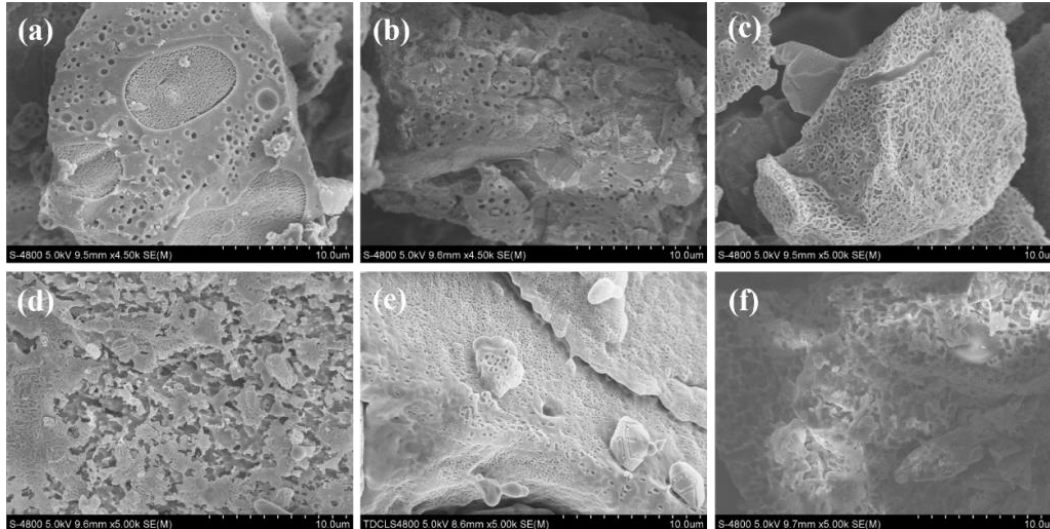
Figure 4. SEM images of poly(S-MVT)s with different MVT contents of ( a ) 50%, ( b ) 40%, ( c ) 30%, ( d ) 20%, ( e ) 15%, ( f ) 10%.